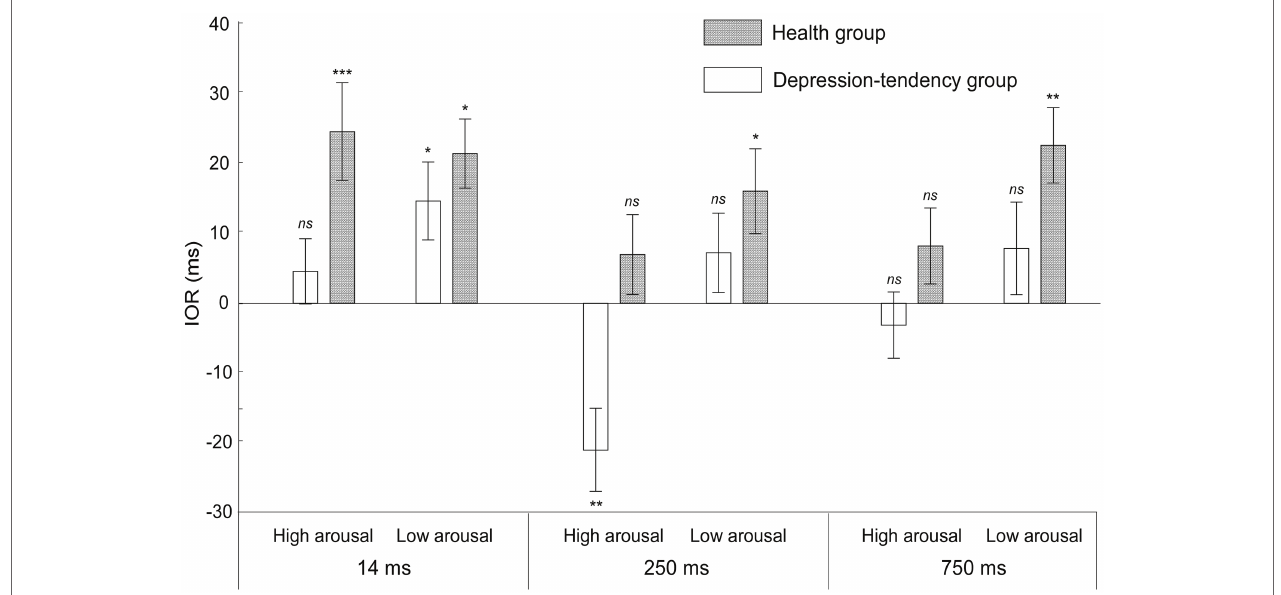
FIGURE 2 | The inhibition of return (IOR) values of the depression-tendency group and the health group were measured at different SOAs (14, 250, and 750 ms) and two arousal levels (high arousal and low arousal). IORs were calculated by subtracting the RT under the valid cue from the RT under the invalid cue. The interval p of the t- test between valid cue and invalid cue was marked. ns, non-significant. * p < 0.05, ** p < 0.01, and *** p <